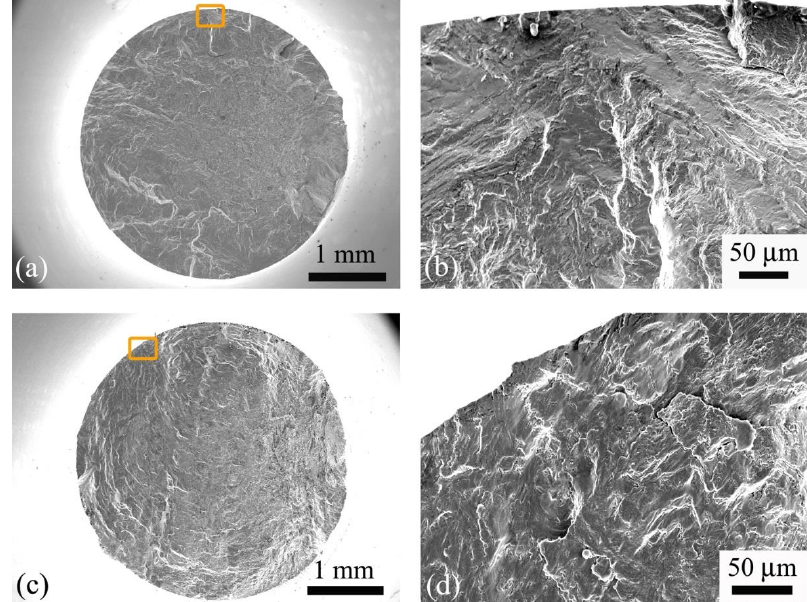
Figure 4. SEM images of fracture surface for hourglass specimens. ( a ) and ( b ) Multi-site crack initiation from the specimen surface at nominal stress amplitude σ a = 840 MPa and N f = 1.20 × 10 4 ; ( c ) and ( d ) Single-site crack initiation from the specimen surface at nominal stress amplitude σ a =530 MPa and N f = 6.87 × 10 6 ; ( b ) and ( d ) Magnified view of the rectangular region in ( a ) and ( c ), respectively.